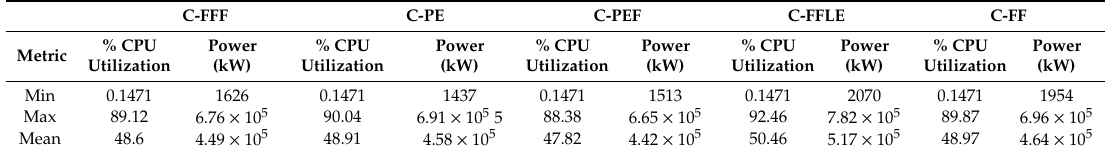
Table 9. Statistical analysis of di ff erent VM placement